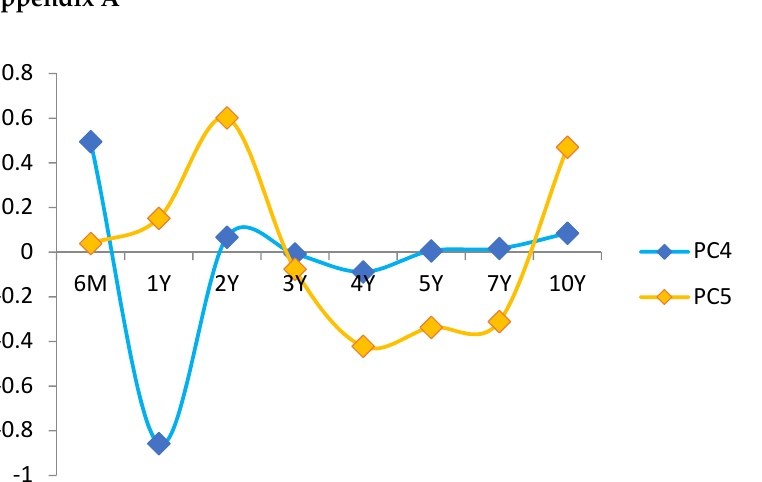
Figure A1. Factor loadings of the fourth and fifth principal components on 25 March 2022. Source: Bloomberg, own computation of PCs with the use of a VBA add-in developed by Leonardo Volpi.